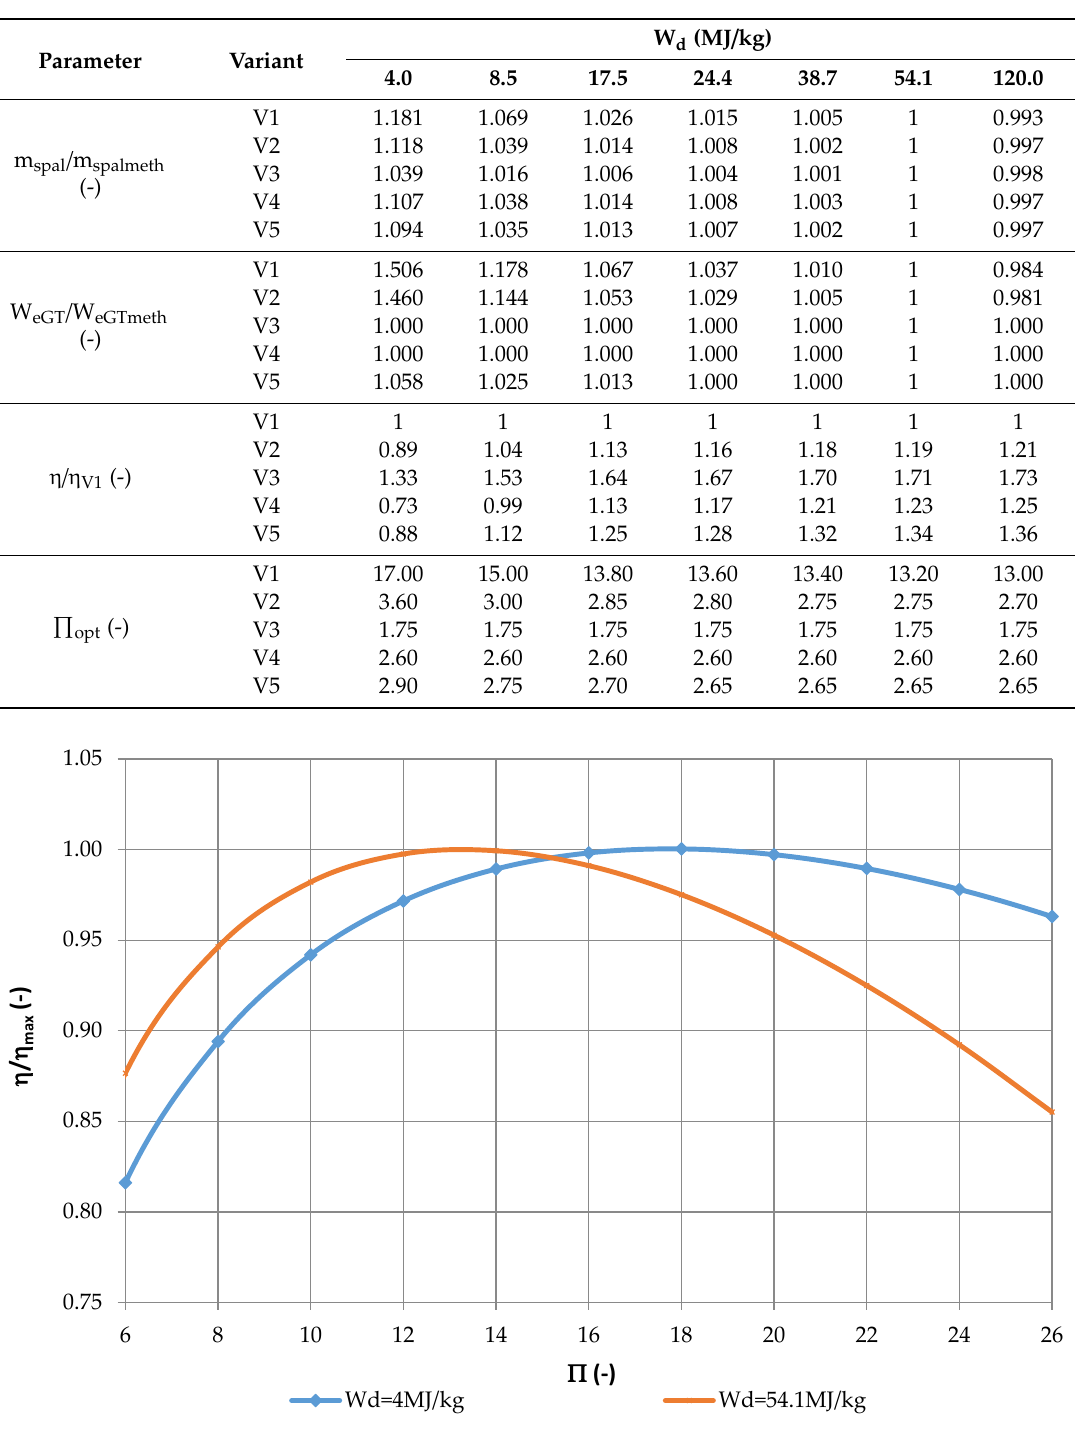
Figure 2. The e ff ect of a compression on the value of the e ffi ciency referred to the maximum value of Figure 2. The effect of a compression on the value of the efficiency referred to the maximum value of variant 1 for two exemplary variant 1 for two exemplary fuels.